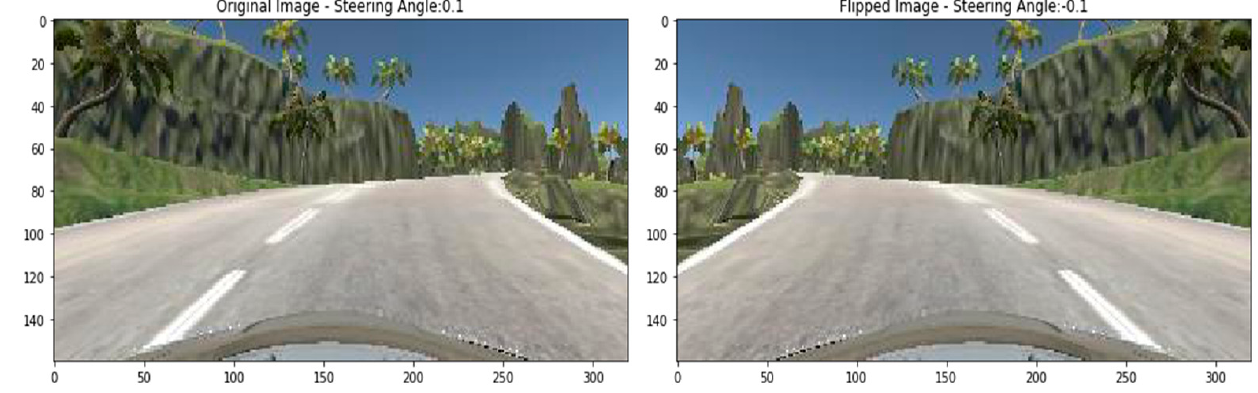
Figure 14. Flipped image. Figure 14. Flipped